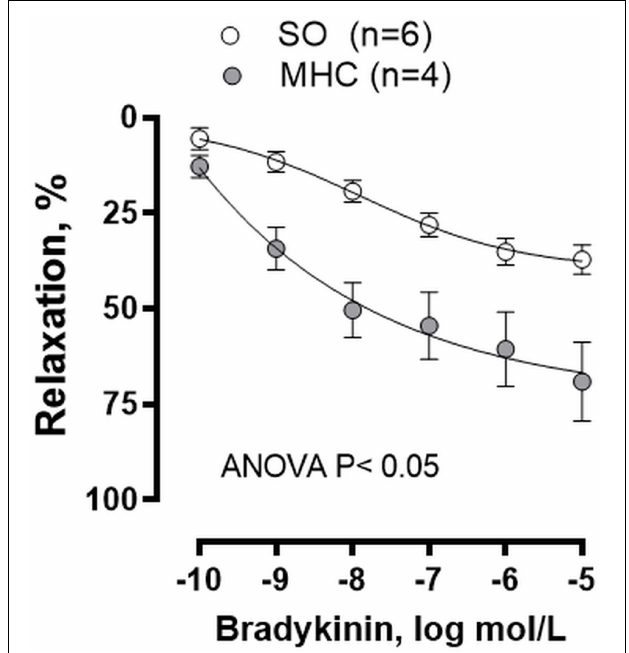
FIGURE 2 | Effect of microsurgical liver cholestasis (MHC) on the concentration-dependent relaxation to bradykinin in rat middle cerebral arteries. Sham-Operated (SO): n = 6; MHC: n = 4. Results (mean ± SEM) were expressed as a percentage of the initial contraction elicited by